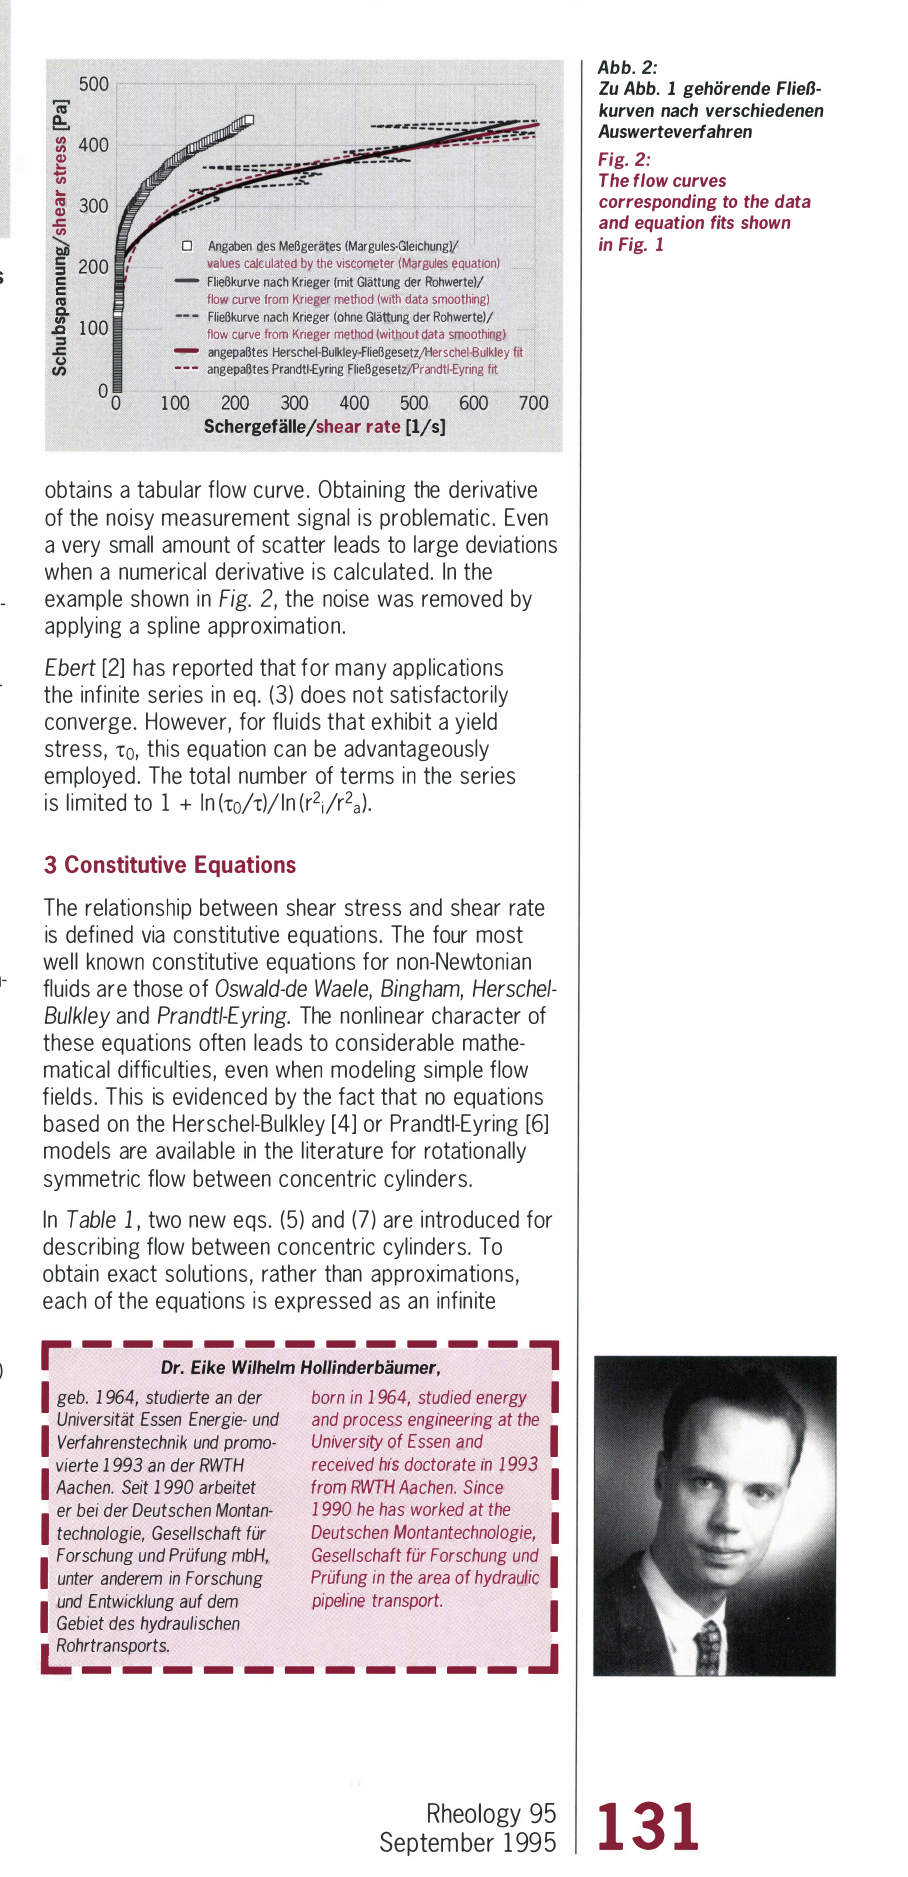
Fig. 1: The raw data for a concentrated suspension of flotation tailings and fits of two constitutive equations. Geometry of the concentric cylinders: r; = 12.5 mm; ra = 24.4 mm; I = 37.5 mm